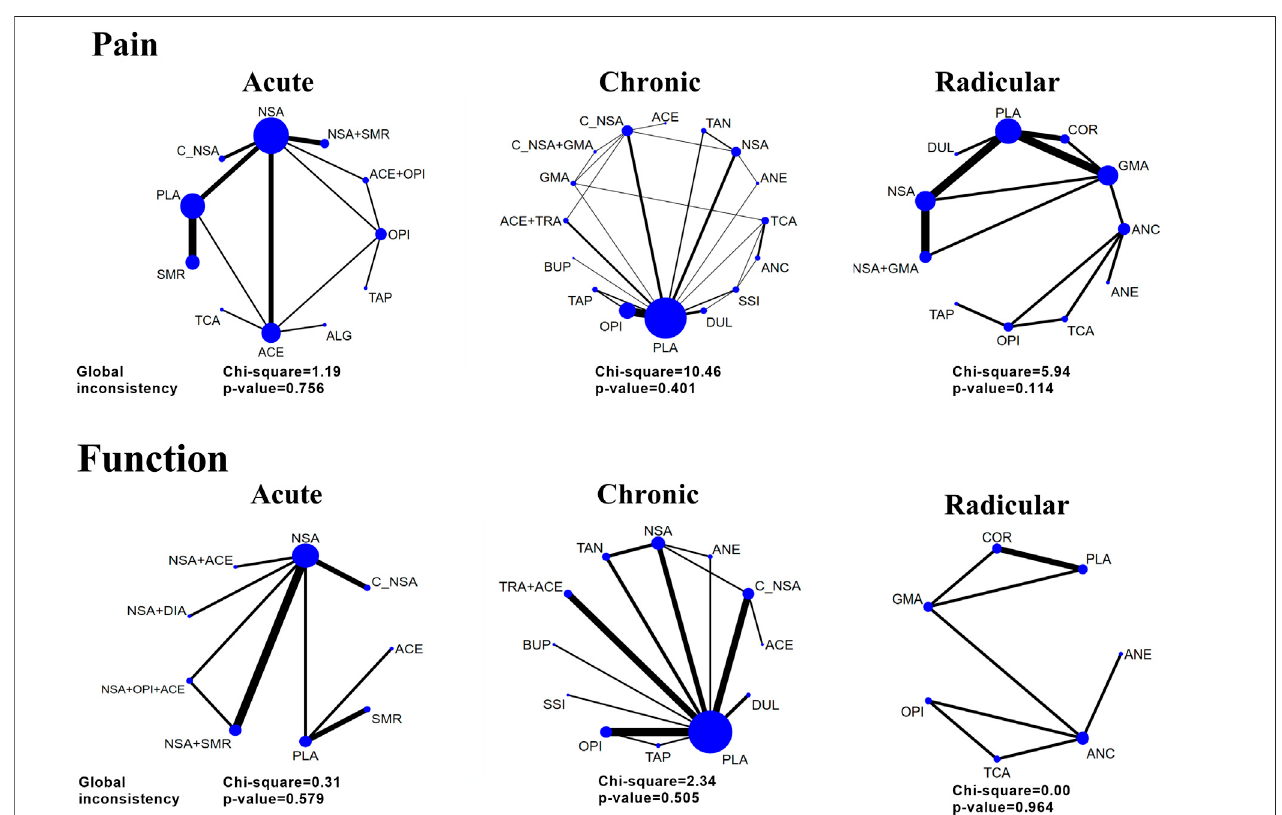
FIGURE 2 | Network and global inconsistency of eligible comparisons for pain intensity and function. Acute, radicular, and chronic low back pain (LBP). The line widths of arcs represent the strength of the relationship between treatments. The wider arc means more direct comparisons between these two treatments.